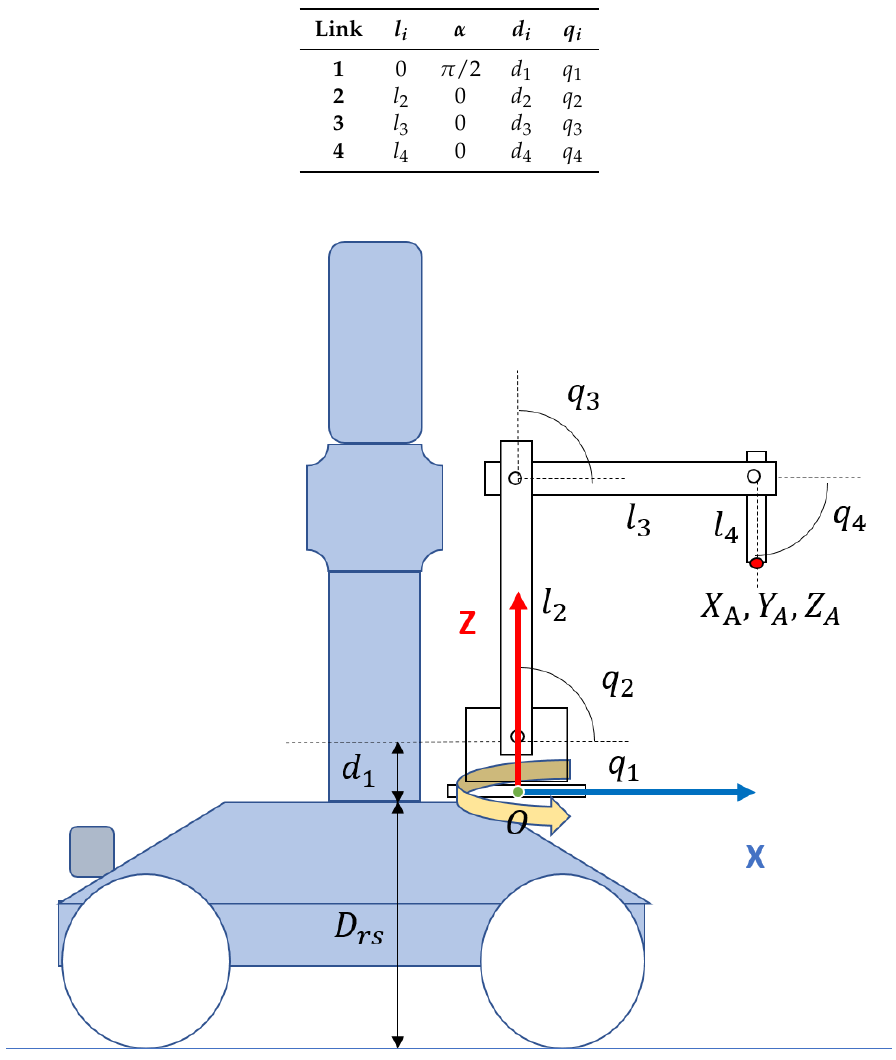
Table 1. Denavit–Hartenberg parameters of the manipulator.